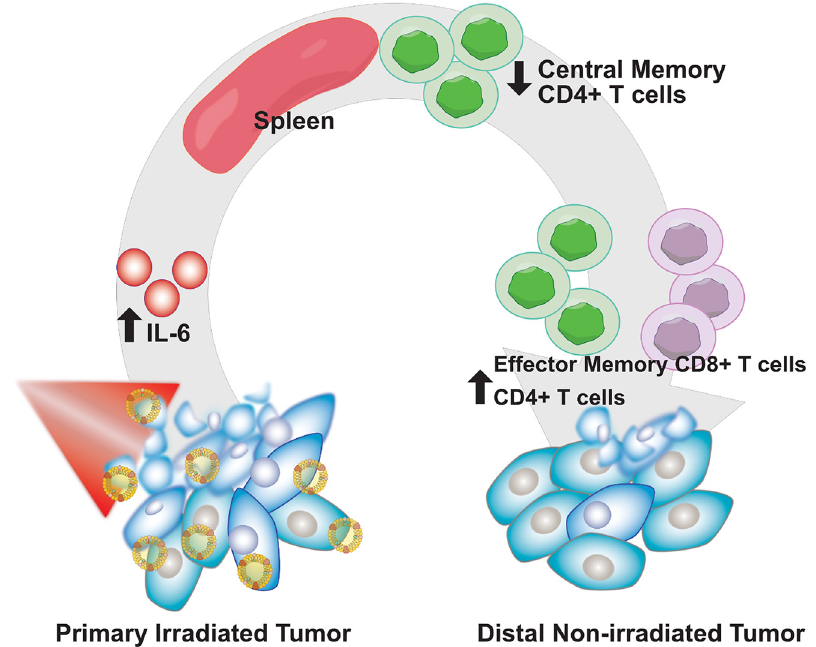
Figure 7: Schematic of immune mechanism underlying the abscopal effect induced by PLP-mediated